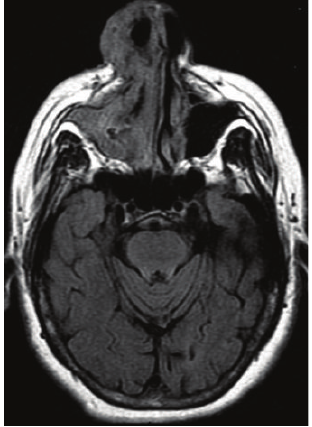
Figure 1: Coronal contrast enhanced CT scan showing large subcutaneous soft tissue density lesion of the nasal ala.